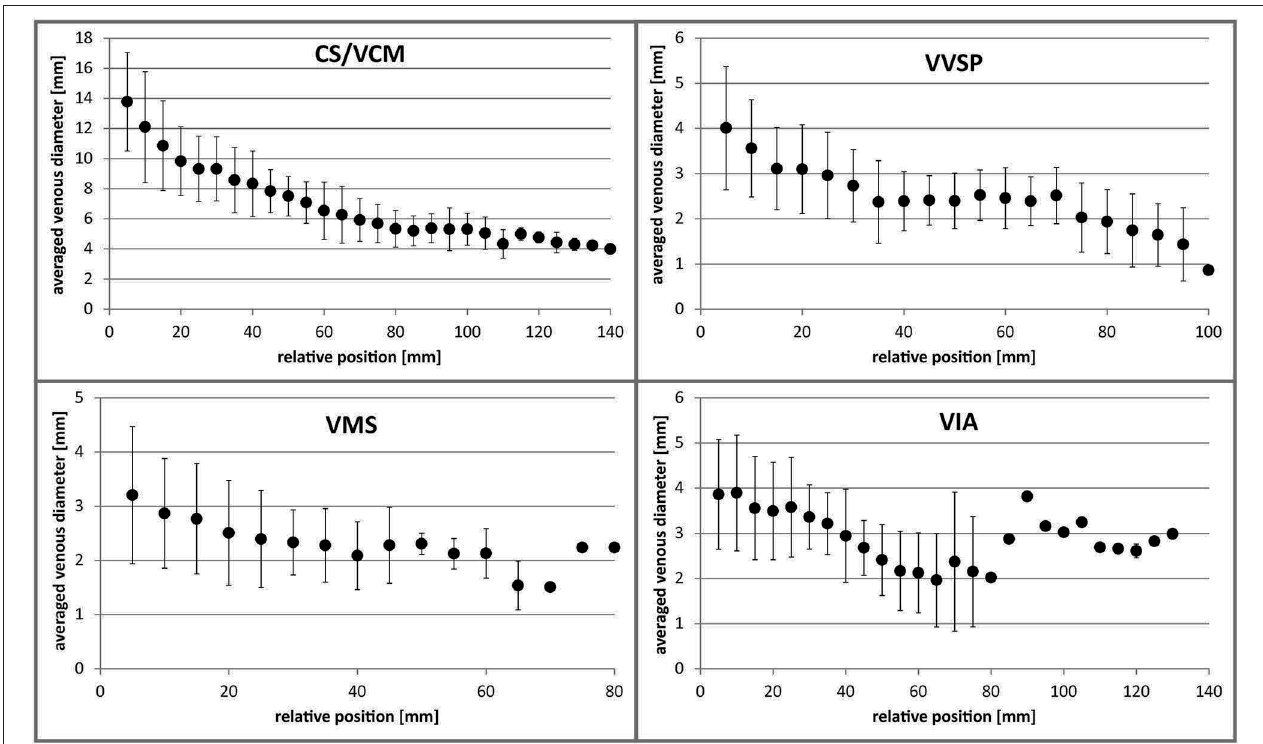
FIGURE 6 | Averaged venous diameters along the distance of the different coronary veins. Error bars indicate standard deviation. Distal values without error bars are single measurements. CS, coronary sinus; VCM, great cardiac vein; VIA, anterior interventricular vein; VMS, left marginal vein; VVSP, left posterior ventricular vein.